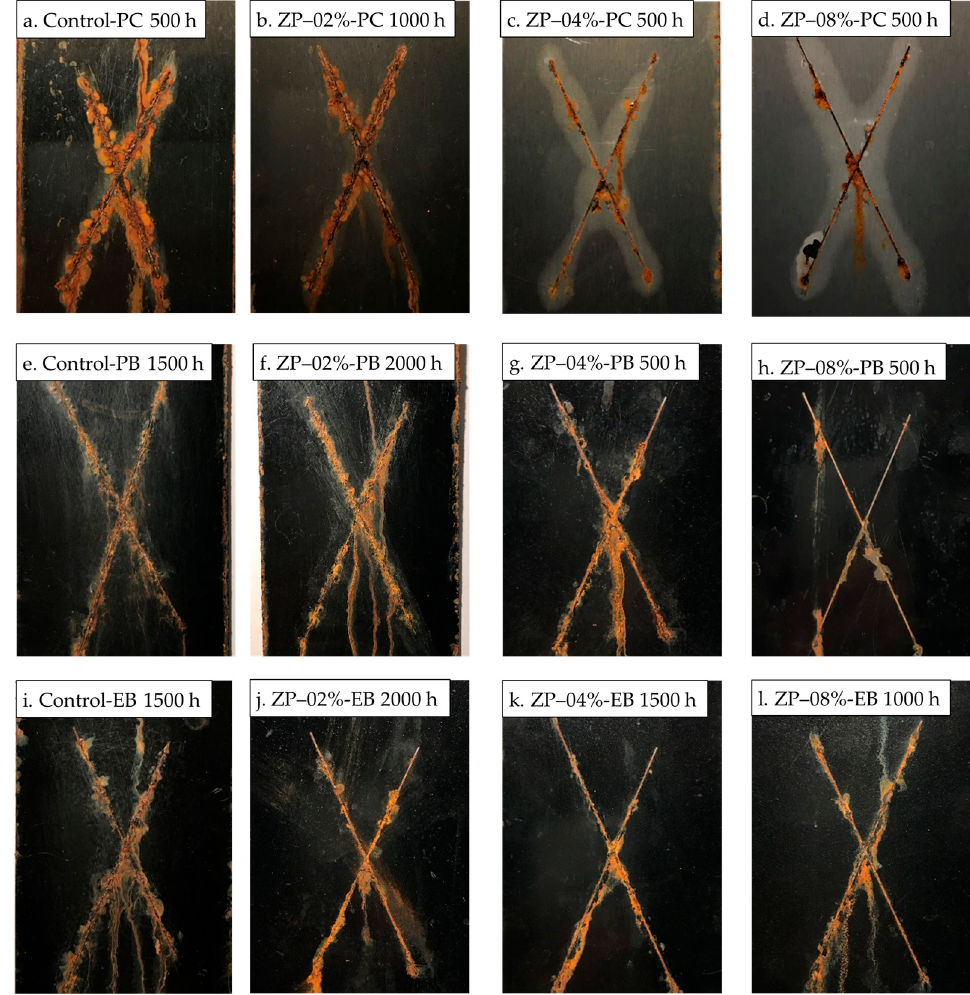
Figure 8. Panel photos after the salt spray test, ZP in PC ( a – d ), PB ( e – h ), and EB ( i – l ).